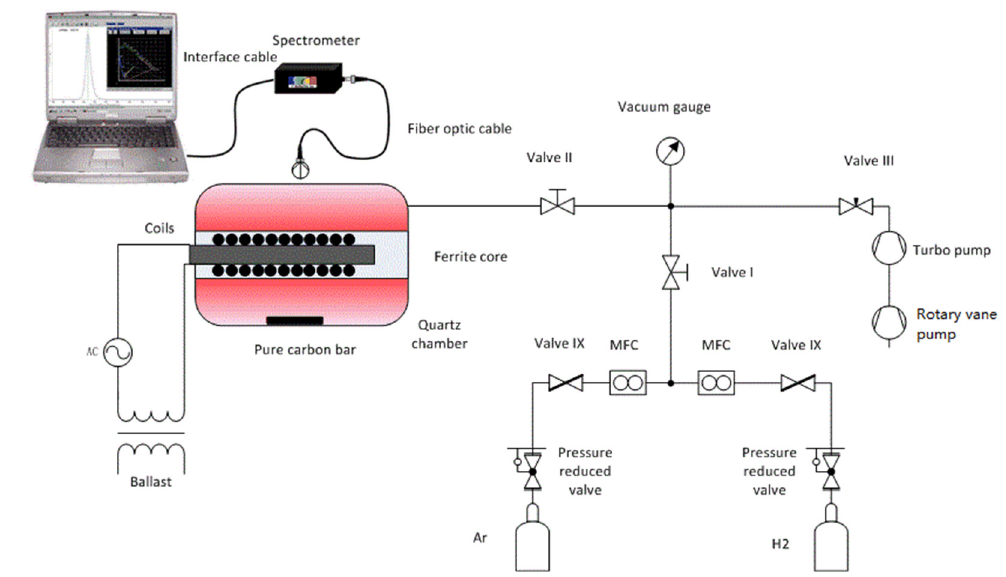
Figure 1. Schematic of the experimental setup.